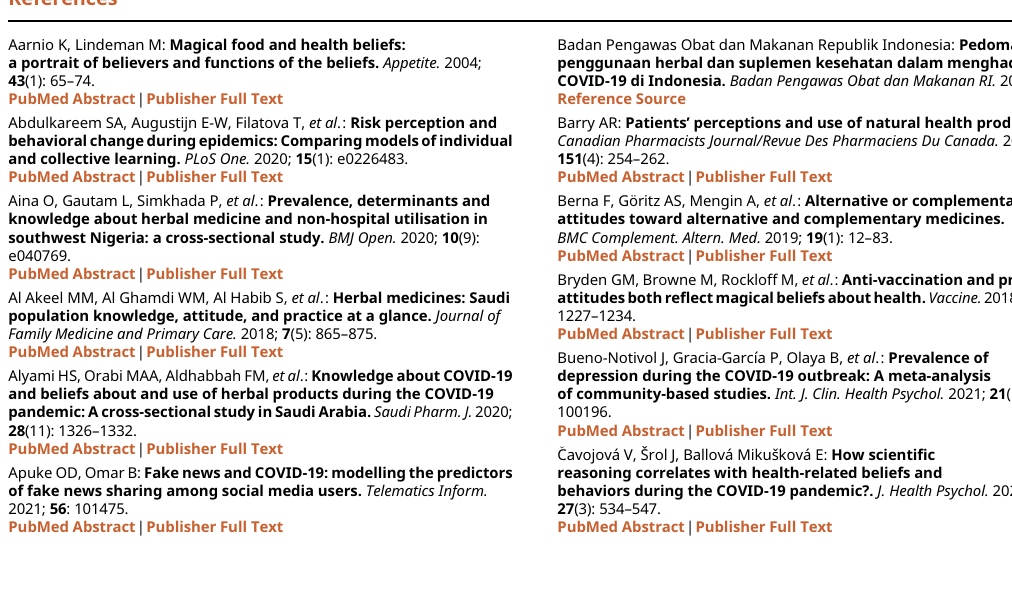
Figshare: Copies of all questionnaires used.pdf, https://doi.org/10.6084/m9.figshare.19618866.v1 (Rias, 2022b). This project contains the following extended